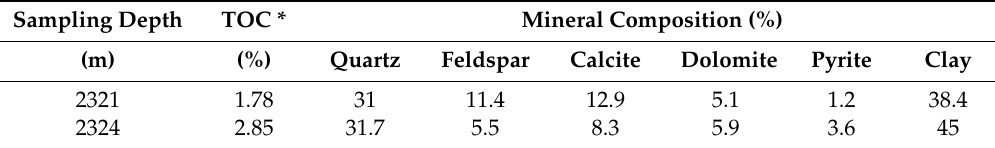
Table 1. Organic and inorganic mineral composition of shale samples.